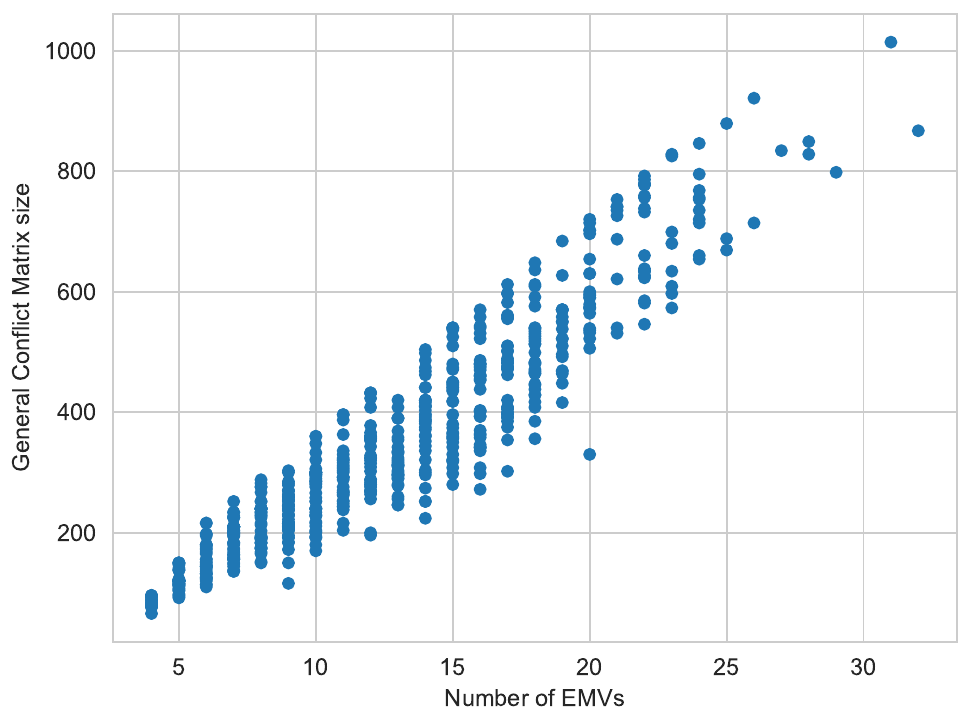
Figure 10. A figure equivalent to Figure 11 with respect to CM size instead of number of EMVs. The lower the solutions’ energy value, the better.